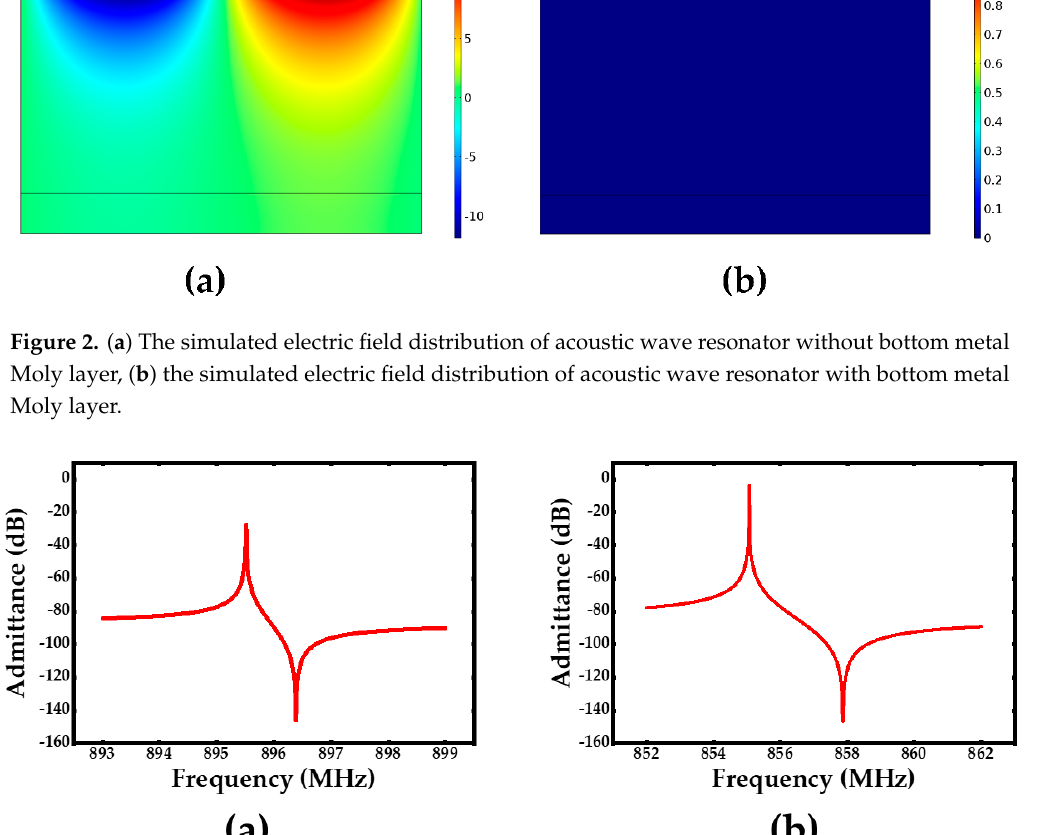
Figure 3. ( a ) The simulated admittance of acoustic wave resonator without bottom metal Moly layer, ( b ) the simulated admittance of acoustic wave resonator with bottom metal Moly layer.